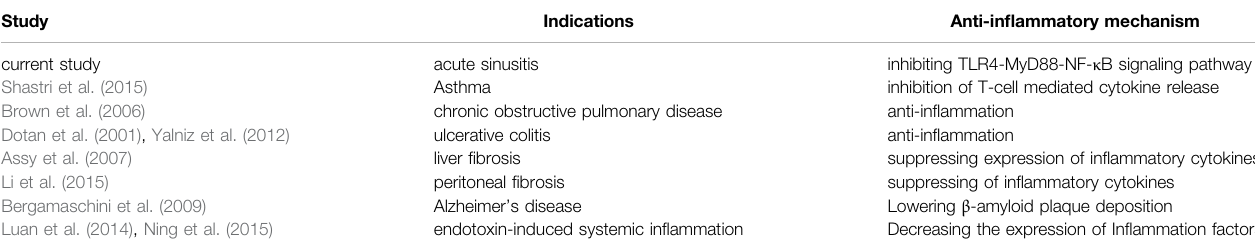
TABLE 1 | Anti-in fl ammatory effect of LMWH. Study Indications Anti-in fl ammatory